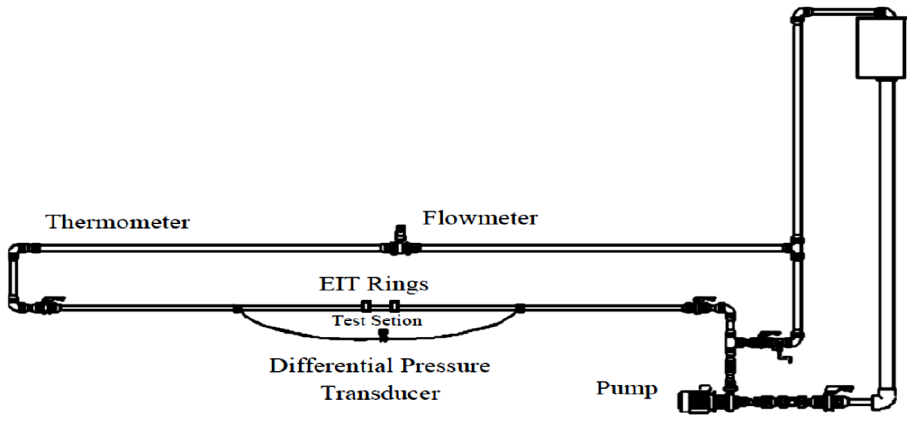
Figure 6. Pilot rig schematic. Figure 6. Pilot rig